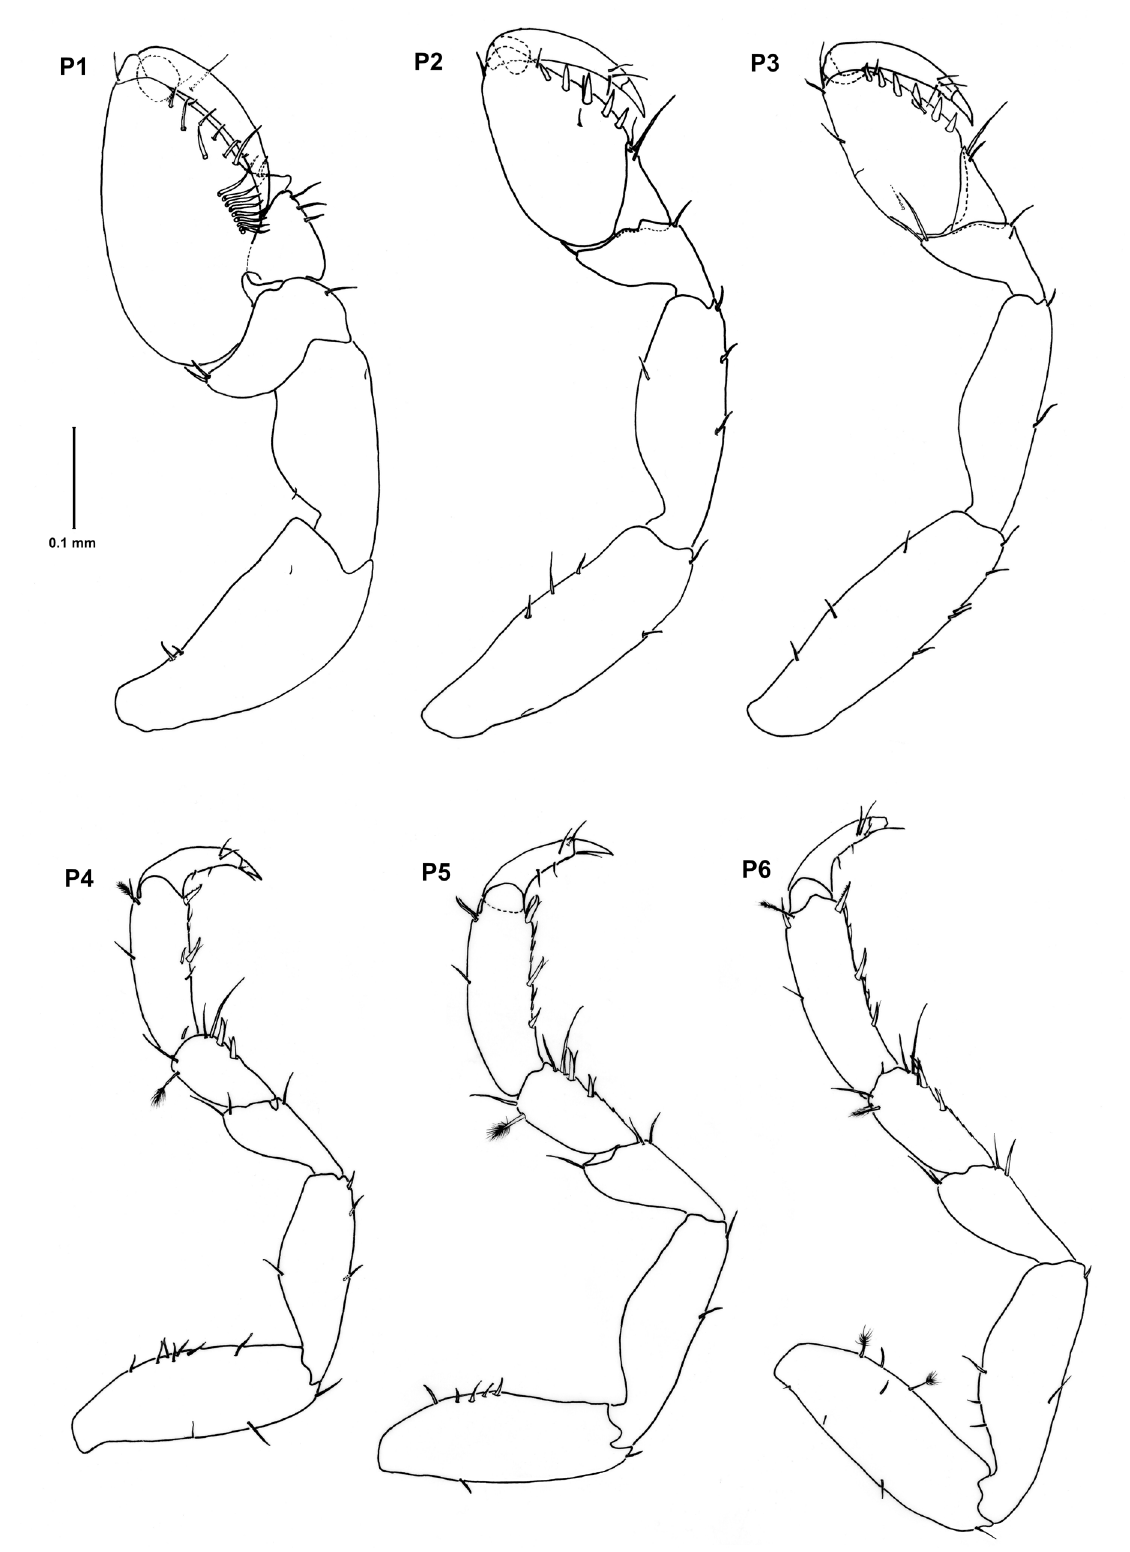
Fig. 33. Colanthura gerungi sp. nov. , ♀, allotype (MZB Iso 110). Abbreviation: P1–P6 = pereopods